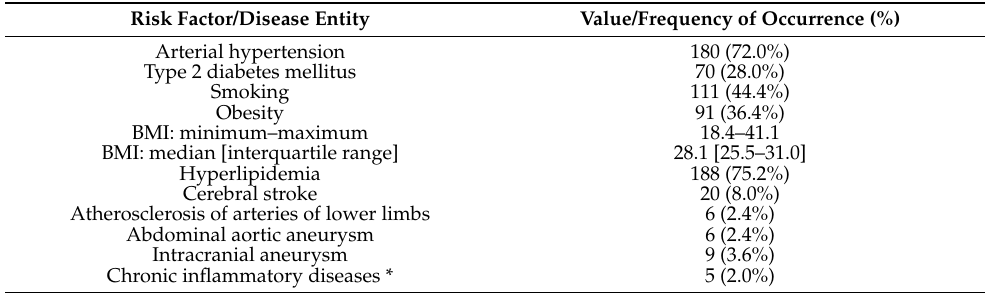
Table 3. Risk factors of atherosclerosis and other vascular or chronic inflammatory diseases in the history of the patients in the studied group.